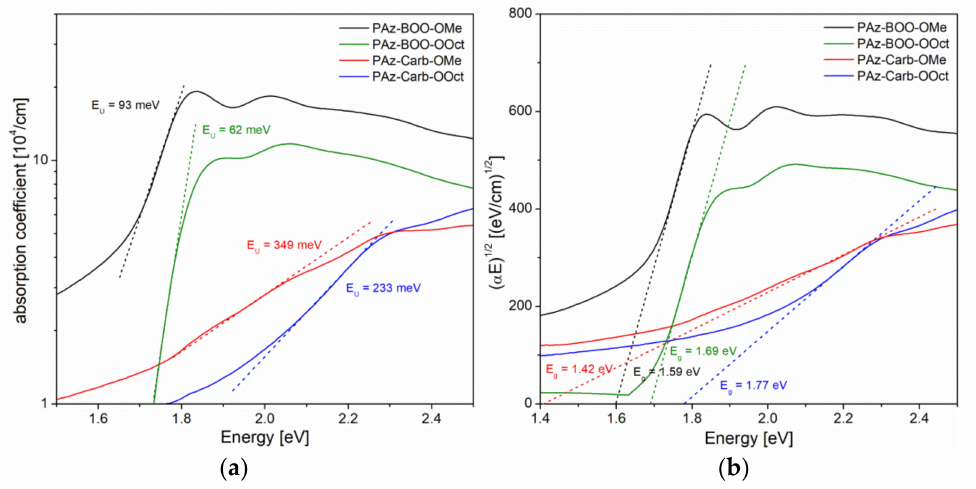
Figure 6. Absorption edge parameters of investigated imines: ( a ) Urbach energies and ( b ) energy